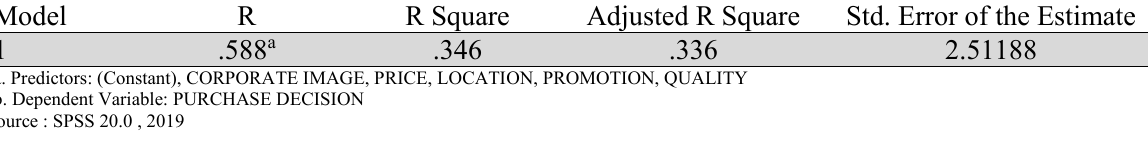
Coefficient Determinant Test Model